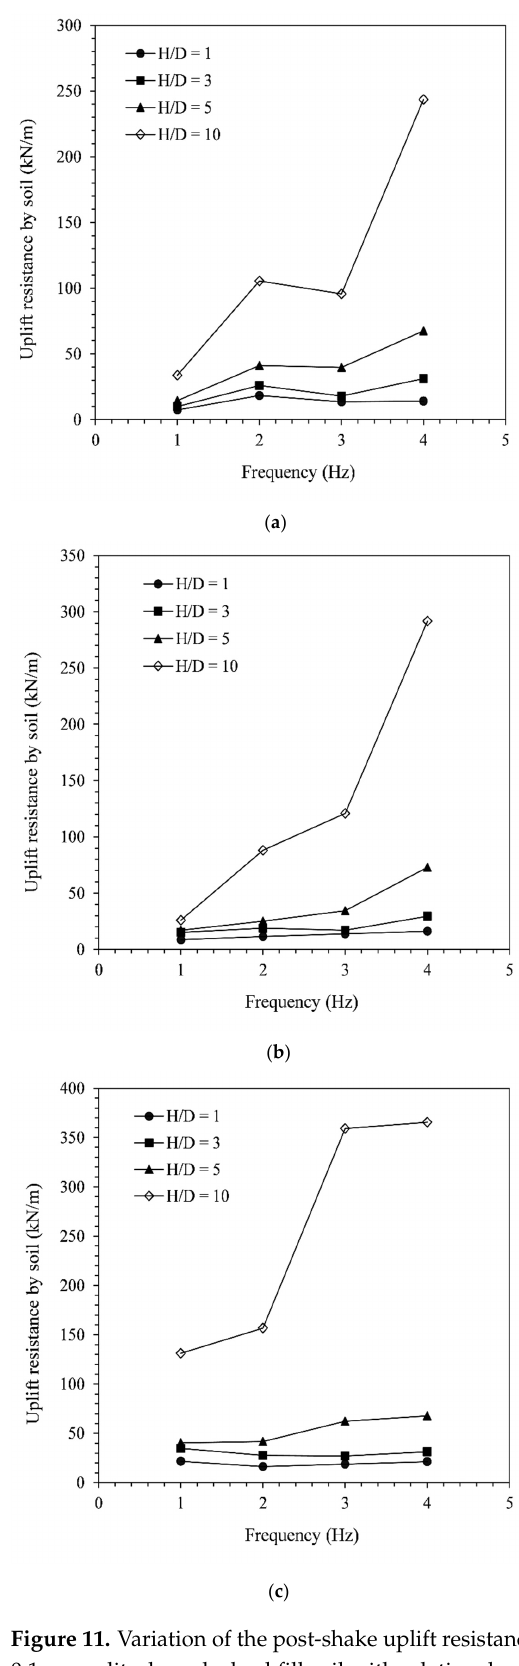
Figure 11. Variation of the post-shake uplift resistance with the frequency of the seismic signal with a 0.1 g amplitude and a backfill soil with relative densities of ( a ) 40%, ( b ) 50% and ( c ) 60%. The dependency of the post-shake uplift resistance on the seismic signal amplitude is shown in Figure 12 for different seismic frequencies and pipe embedment depths. It can be observed that the relationship between the uplift resistance and the seismic amplitude depends on the signal frequency and on the pipe embedment depth. In the same figure, it can also be observed that initially, the uplift resistance decreased with increasing seismic signal amplitude, until it reached the lowest value. Thereafter, the uplift resistance started increasing. For example, in Figure 12a, the uplift resistance corresponding to the 3 Hz